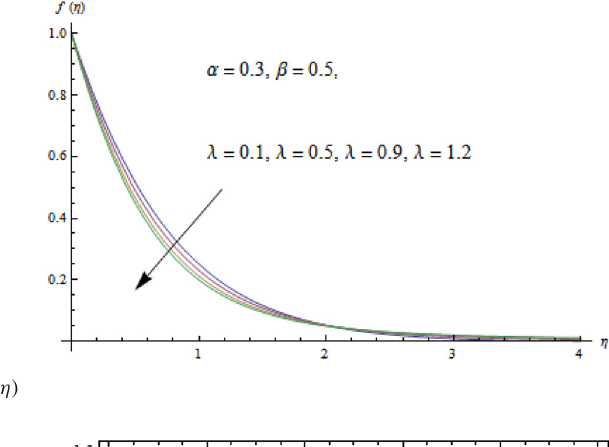
Fig. 7 Impact of λ on f (cid:5) (η)